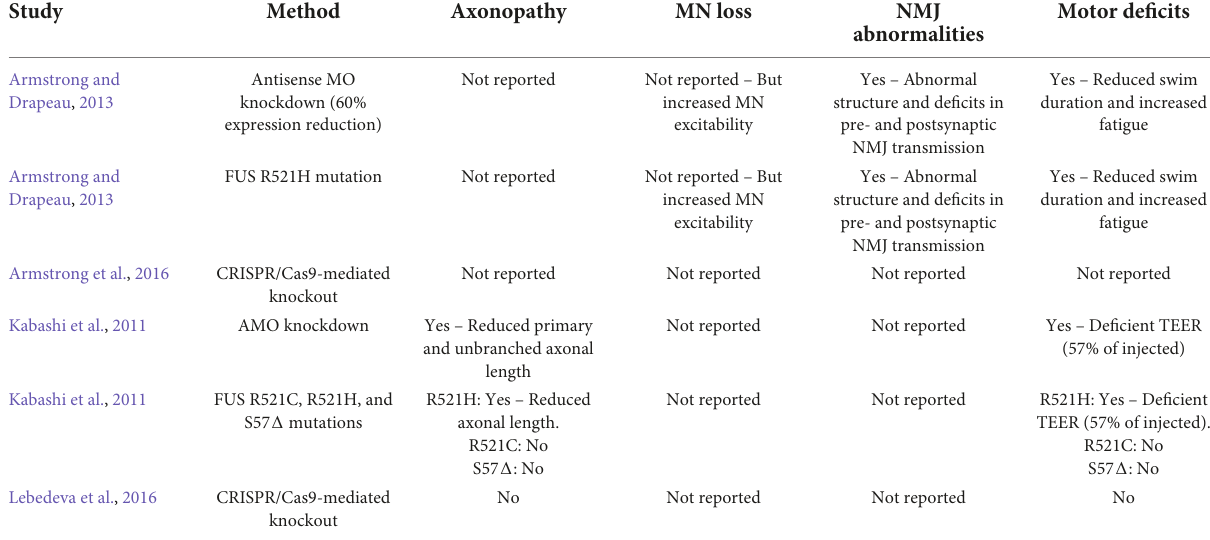
TABLE 7 Zebrafish models of FUS